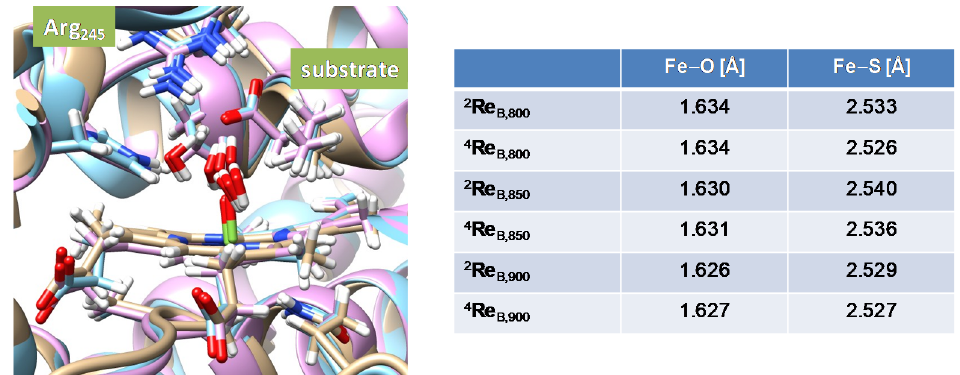
Figure 8. Quantum mechanics/molecular mechanics ( QM/MM) optimized geometries of Compound I in the doublet and quartet spin states for snapshots Sn 800 , Sn 850 and Sn 900 . Fe ‒ O and Fe ‒ S distances